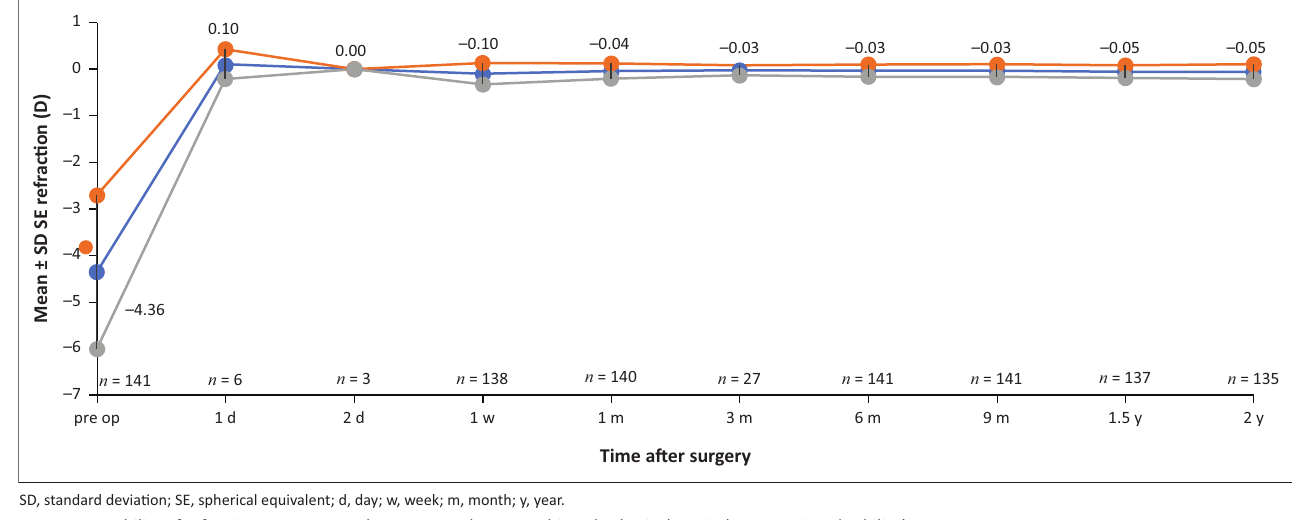
FIGURE 5: Stability of refraction over 24 months. Attempted versus achieved spherical equivalent over time ‘stability’.